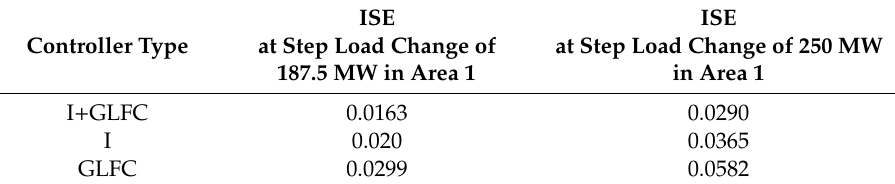
Table 3. The Performance index of ∆ f 1 .